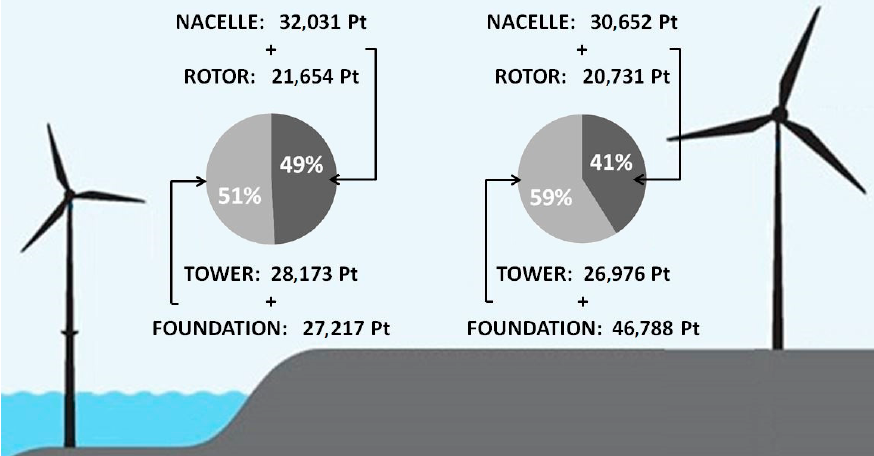
Figure 10. Results of grouping and weighing environmental effects of the most important elements of land-based and offshore wind power plants for all categories of influence. Authors’ own research.